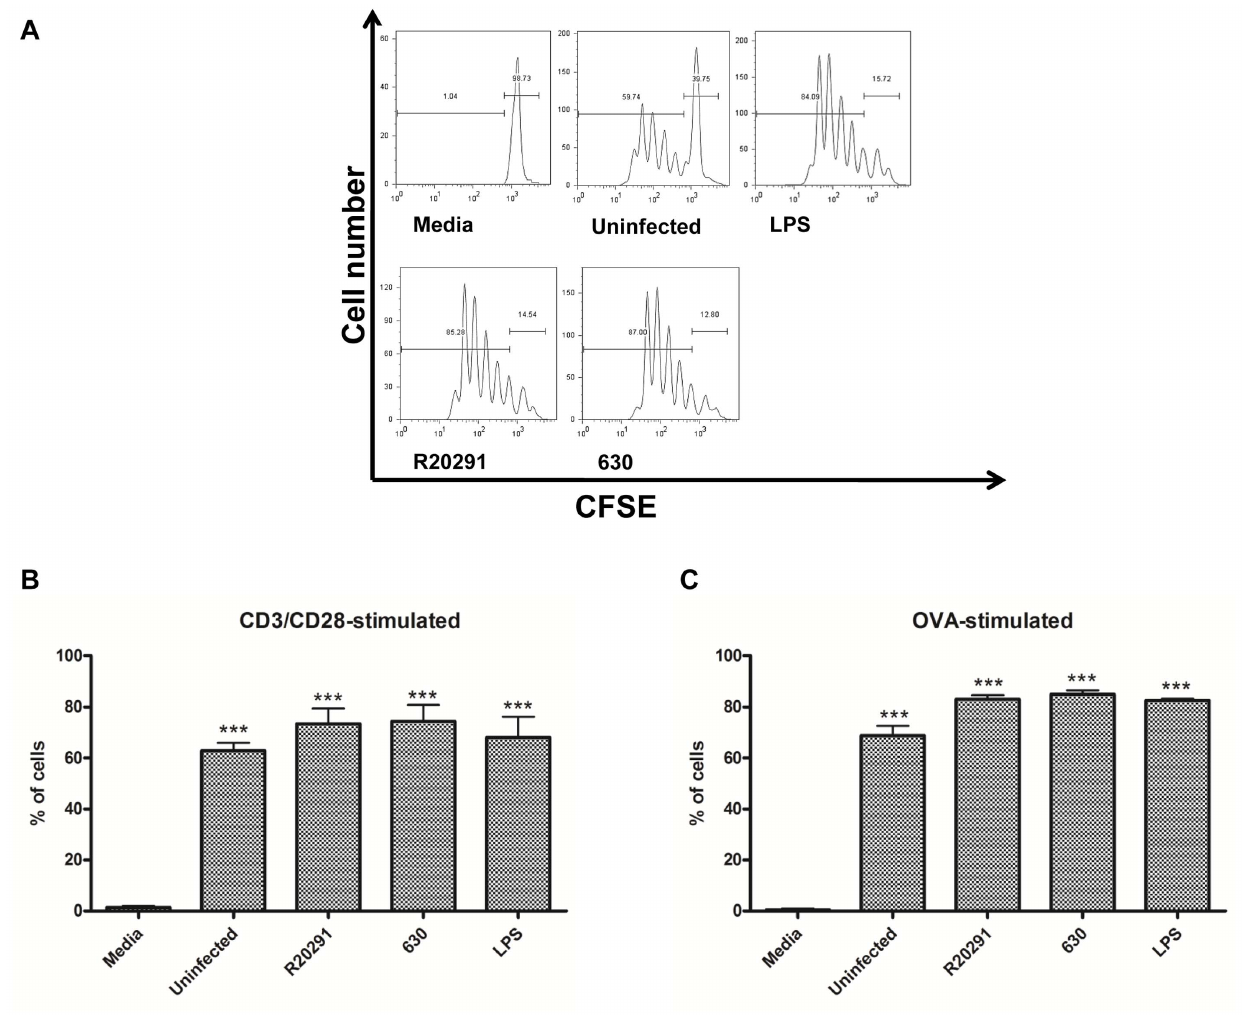
Figure 6. Splenocyte and Naı¨ve CD4 + T cell proliferation in response to C.difficile -stimulated BMDCs. WT BMDCs were infected with PFA-fixed C. difficile strains at an MOI of 50. 24 h post-infection, infected BMDCs were co-cultured with CFSE-labelled splenocytes in the presence of anti-CD3/CD28. Proliferation of CD4 + gated cells 96 h post stimulation (A). Quantification presented as percentage of proliferating cells (B). Infected BMDCs were co-cultured with CFSE-labelled naı¨ve CD4 + T cells from OT-II transgenic mice in the presence of OVA 323–339 and T cell proliferation was analysed (C). 1 m g/ml LPS utilised as a reference stimulus. ***p , 0.001 represent significant difference from uninfected control cells. Data was analysed using ANOVA with Bonferroni